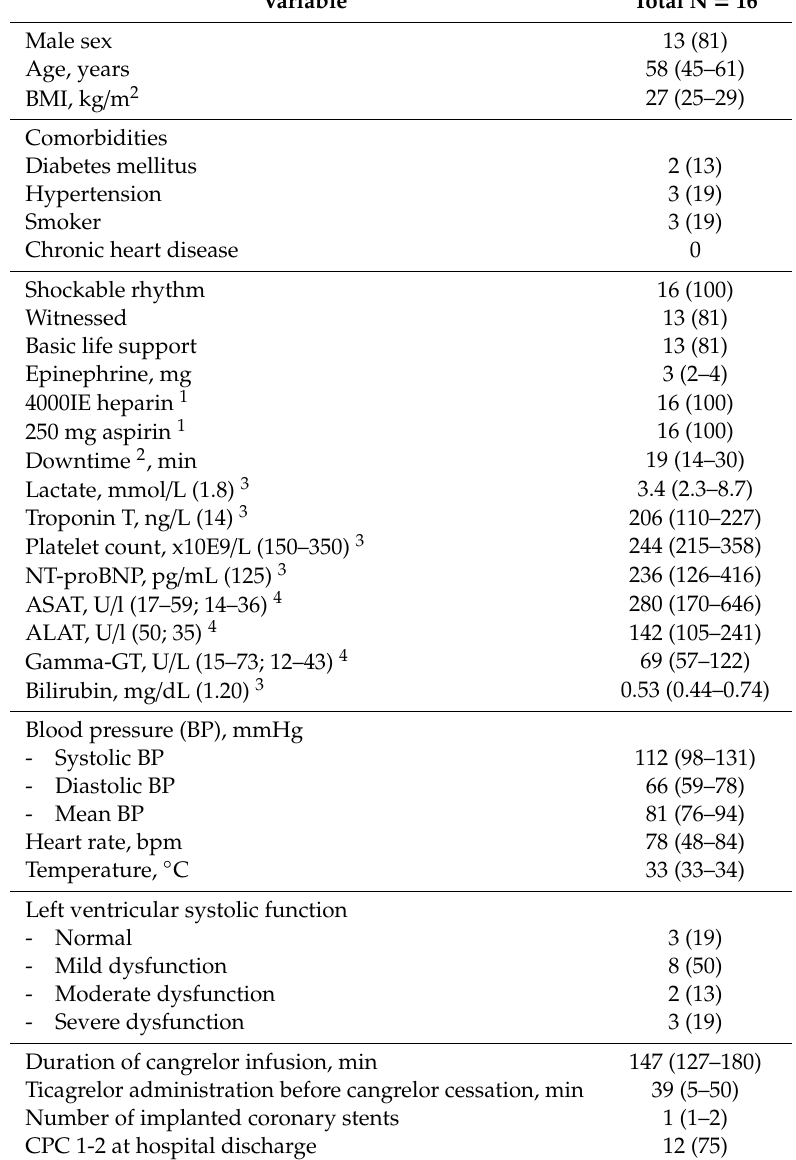
Table 1. Characteristics of study patients. Data are n (%) or median (25–75% IQR). Blood values were measured at the time of stent